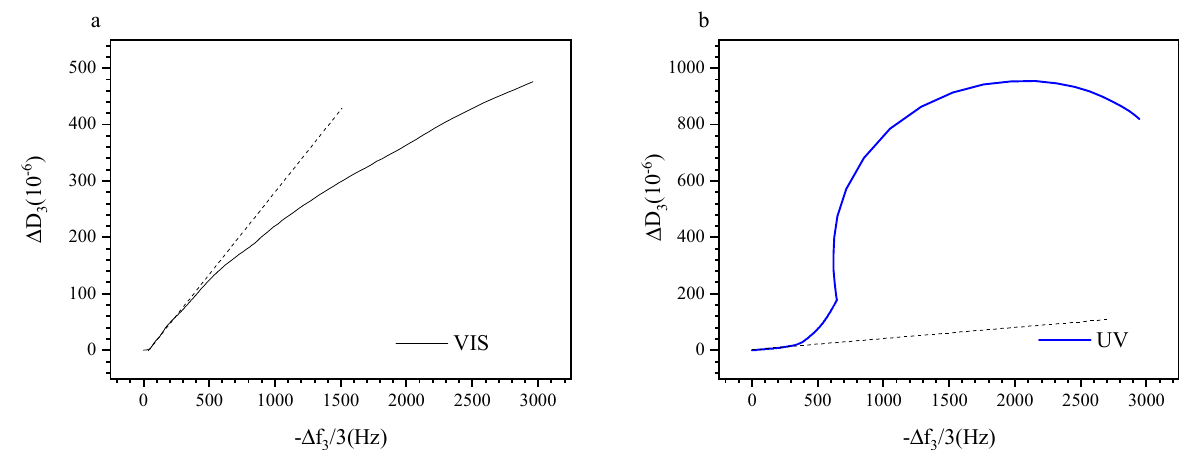
Figure 7. ( a ) Variation of ∆ D 3 as function of − ∆ f 3 /3 when the sensor is continuously exposed to visible light, ( b ) variation of ∆ D 3 as function of − ∆ f 3 /3 when the sensor is irradiated with UV light. Blue curves: upon UV illumination, black curves: upon visible illumination.